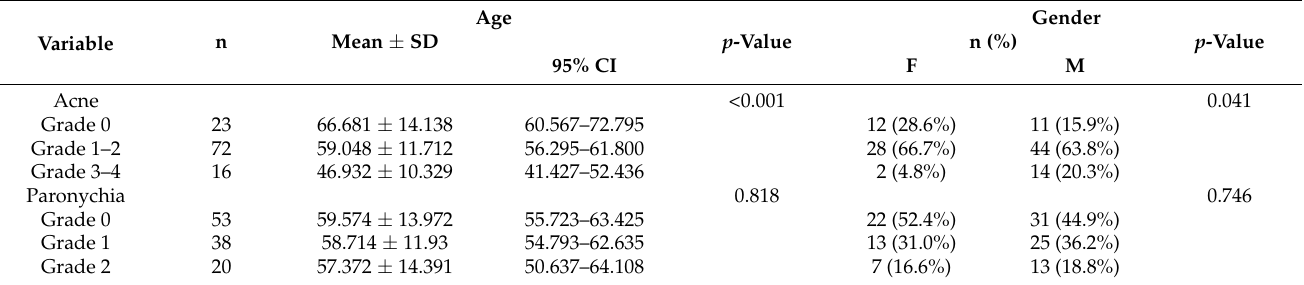
Table 6. Association between skin reactions with Age and Gender (N = 111).